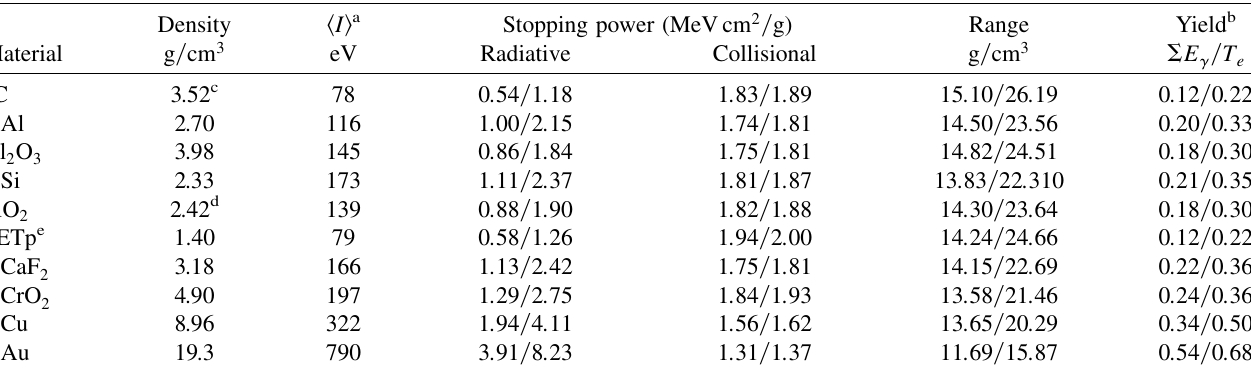
(cid:1) 30 = 60 MeV electrons. e